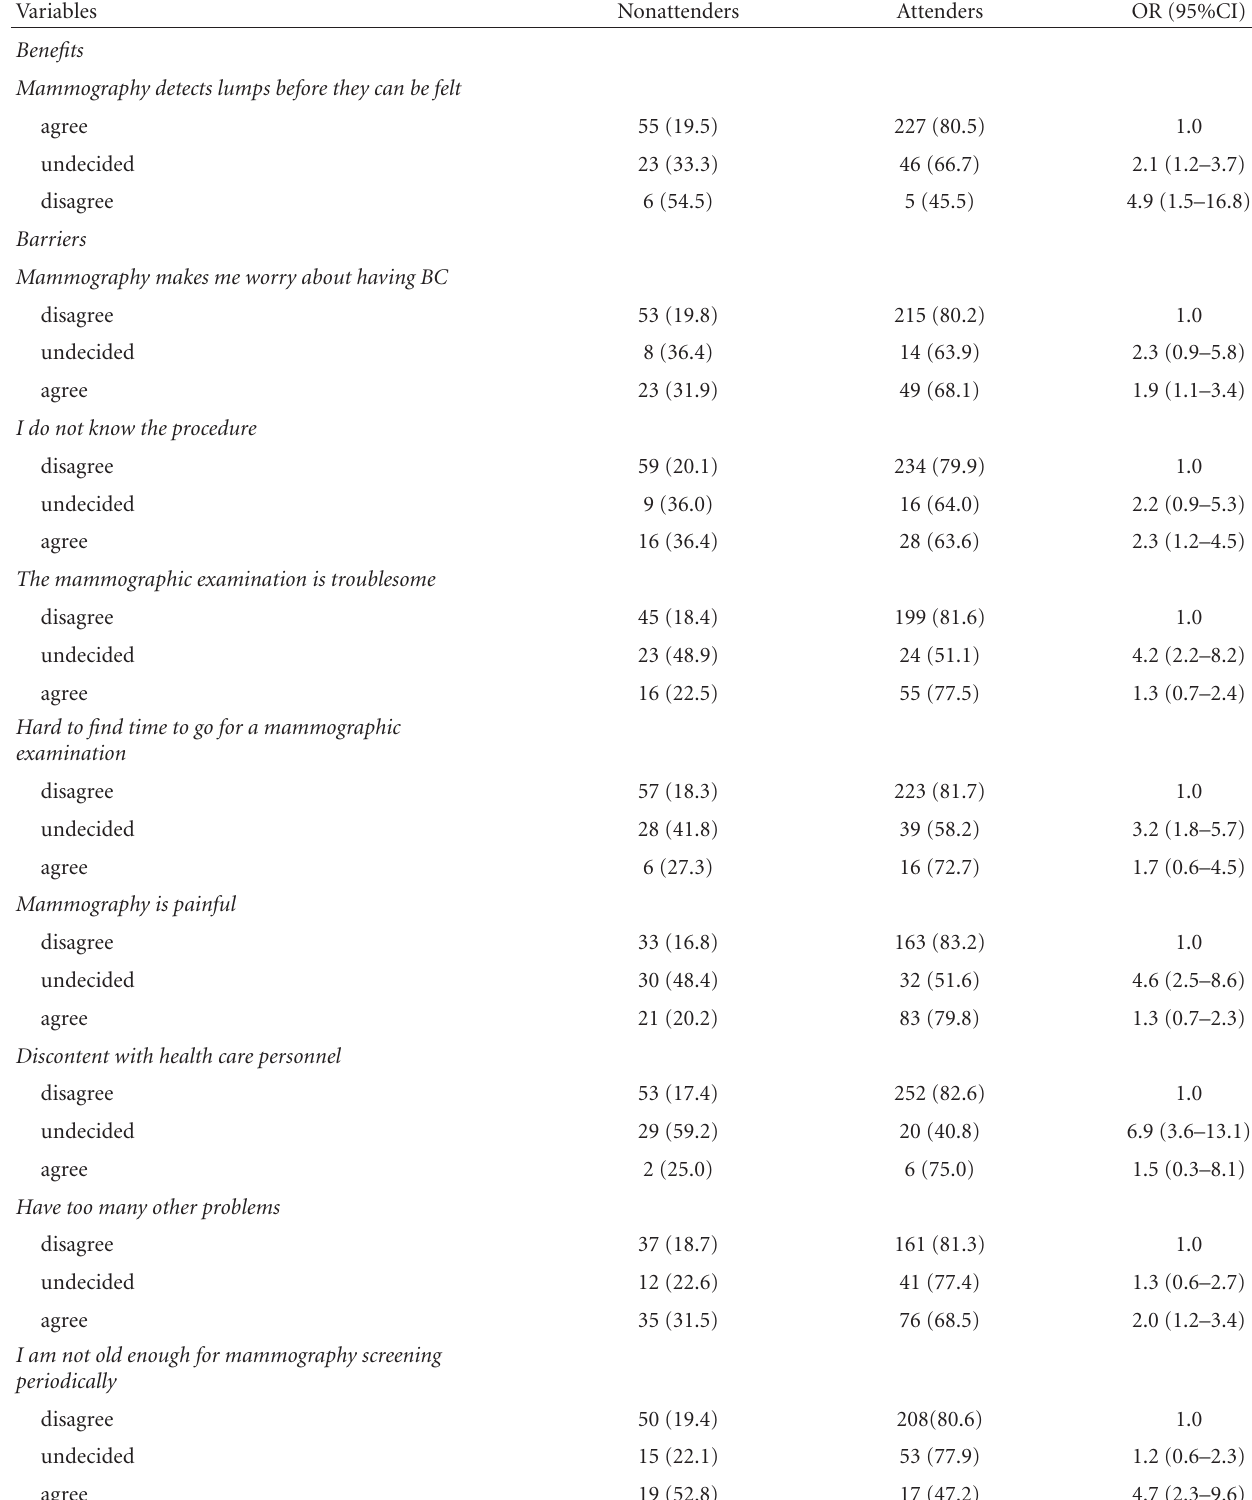
Table 4: Univariate ORs and 95% CIs of nonattendance at mammography screening for single-item variables that were statistically significant in a univariate